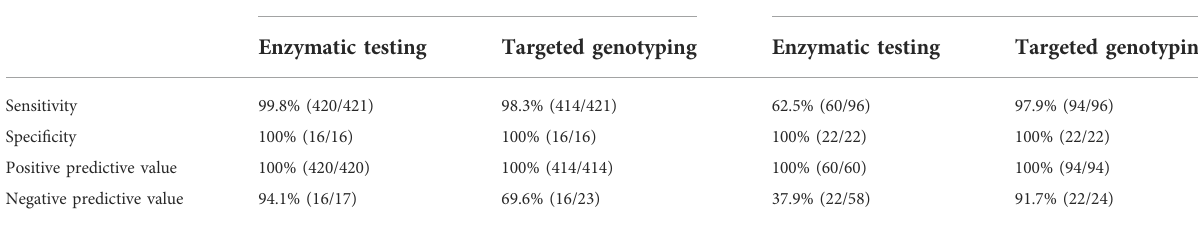
TABLE 3 Diagnostic performances of enzymatic testing and targeted